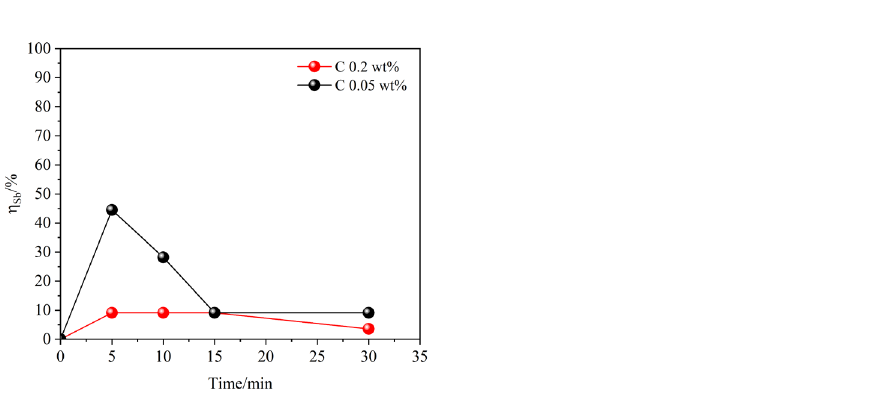
Figure 5. Effect of initial C content in molten steel on Sb removal ratio at T = 1873 K, slag = 5 wt%, initial Sb = 0.06 wt%, and initial CaC 2 = 20 wt%.